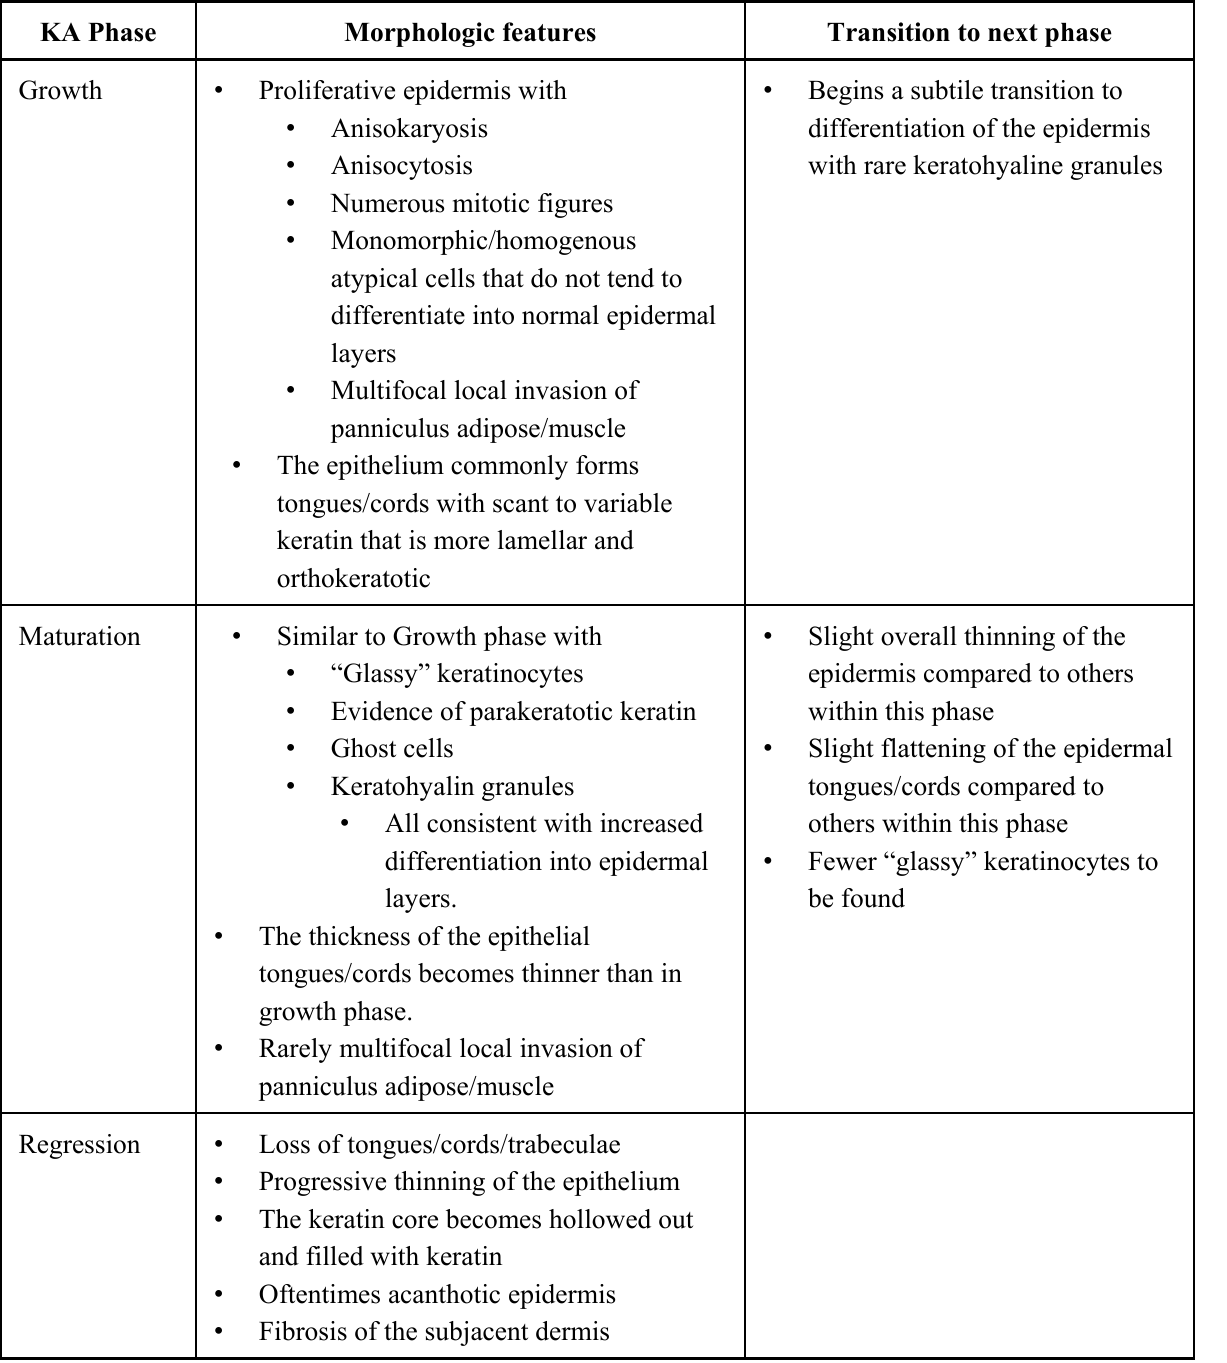
Table 2. Phases of murine KA